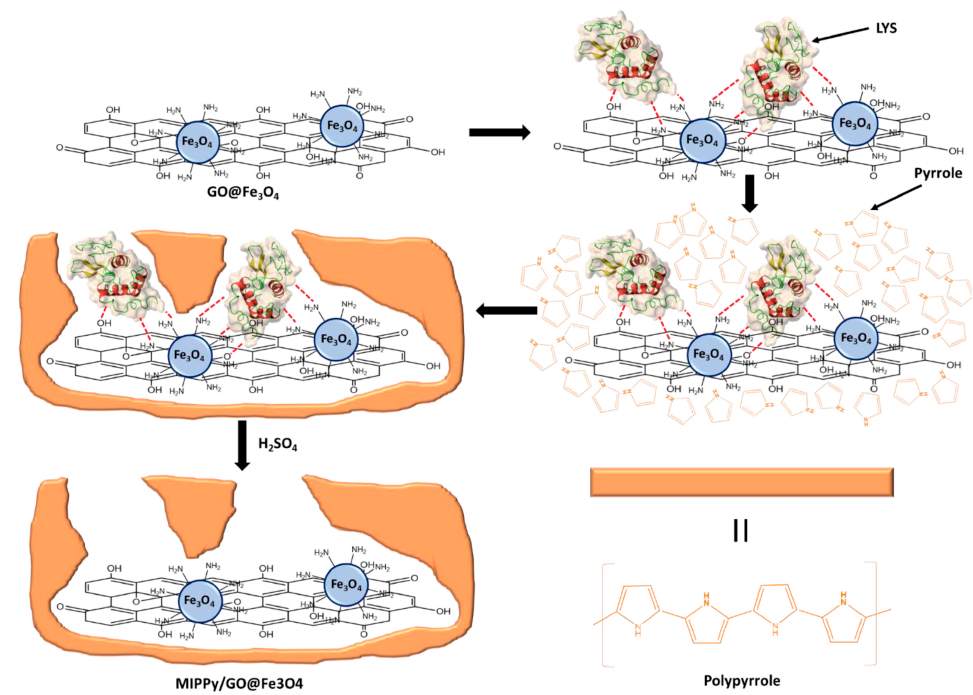
Figure 13. Synthesis process of MIPPy/GO@Fe 3 O 4 . Reprinted from [52], with permission from Open Access MDPI, 2022.